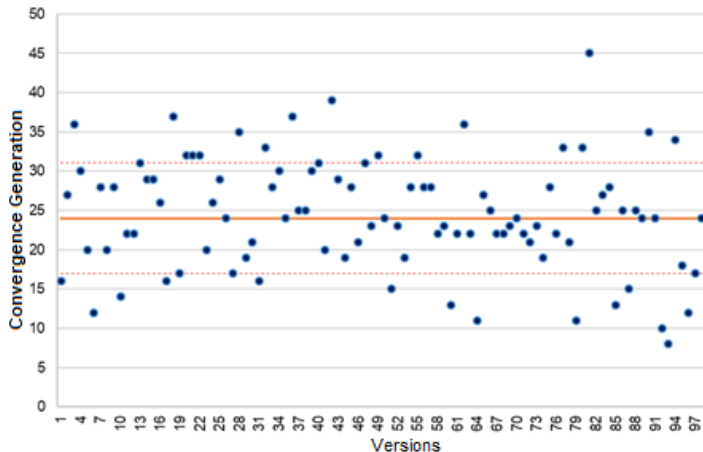
Figure 13. Average generation convergence for FEC.